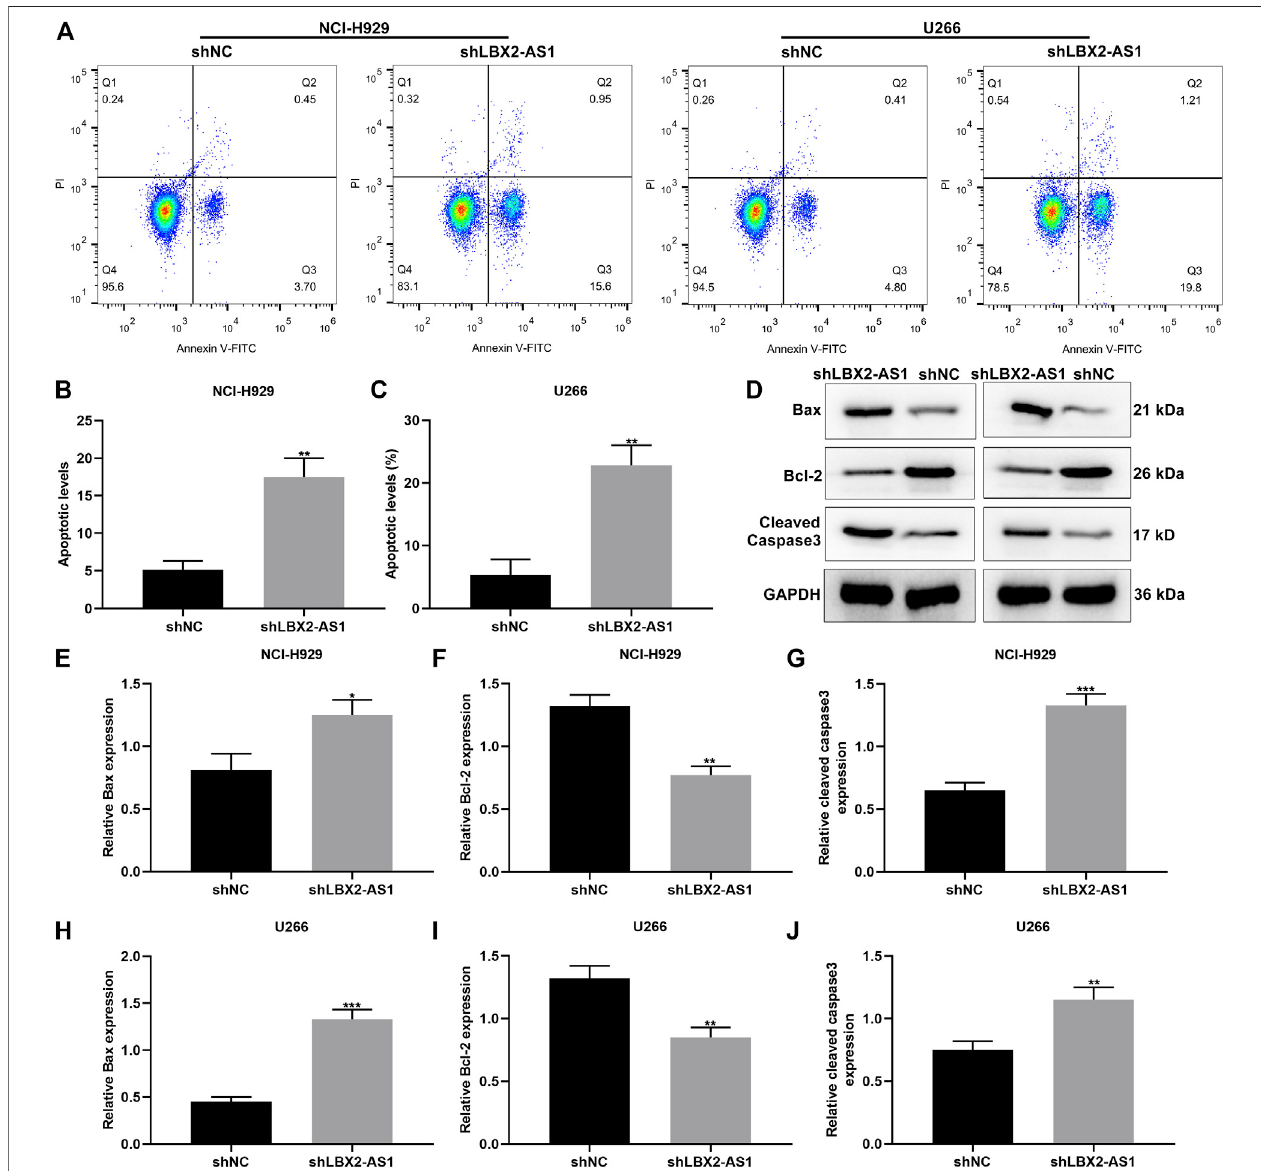
FIGURE 3 | LBX2-AS1 knockdown accelerates apoptosis of MM cells. (A – C) The apoptotic rate of NCI-H929 and U266 cells under transfection by shNC and shLBX2-AS1using fl owcytometryassay. (D) Representativeimagesofproteinbands. (E – J) TheexpressionofBax,Bcl-2andcleavedCaspase3proteinsin (E – G)